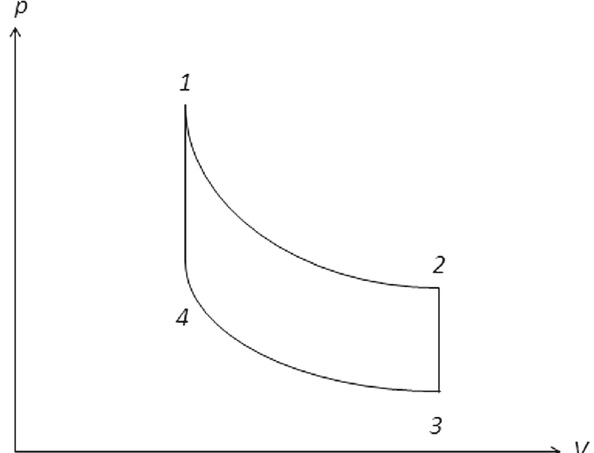
Fig. 10 p x V diagram of a heat engine that produces the maximal effi- ciency adiabatic processes ( S constant) are also isochoric and the cycle represented in Fig. 10 (in which 1 → 2 and 3 → 4 are isothermic processes) will produce the maximal efficiency.